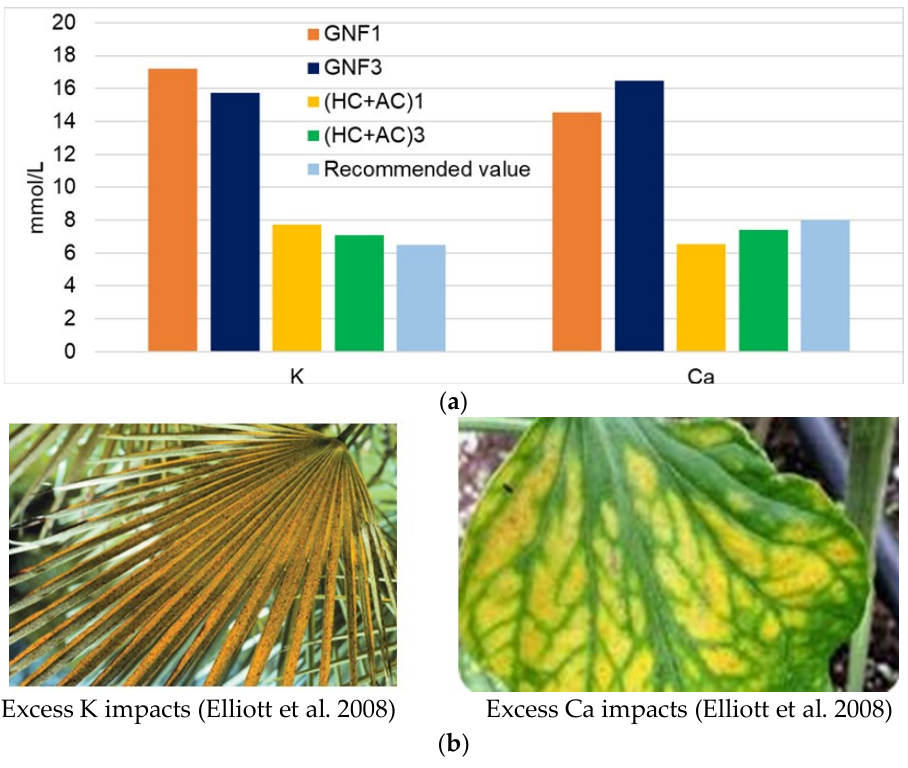
Figure 3. ( a ) Higher concentrations of Ca and K reduced to a safe recyclable level by HC+AC treatments. ( b ) Excess K and Ca impacts on plant growth. Table 9. ( a ) Reactive phosphate (PO 43 − ) mg/L in GNF and treated GNF using HCs and ACs. ( b ) Results of nutrients removal by AC400 and RO from GNF1 and